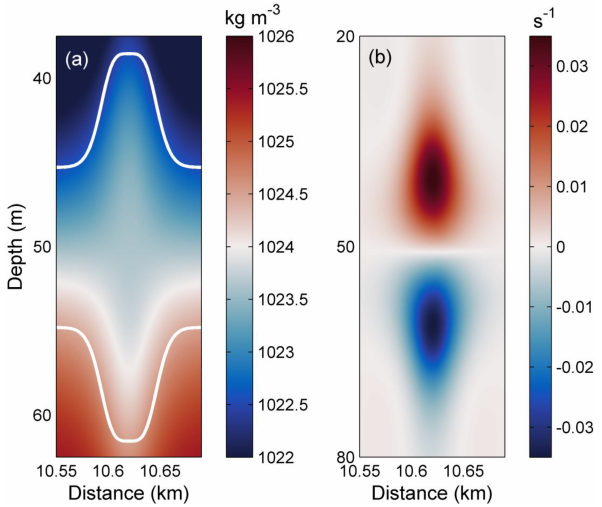
Figure 3. The characteristics of a single mode-2 ISW’s (a) density field and (b) vorticity in the absence of a background shear cur- rent. The white lines in (a) demonstrate the theoretical solution of a mode-2 ISW in the KdV